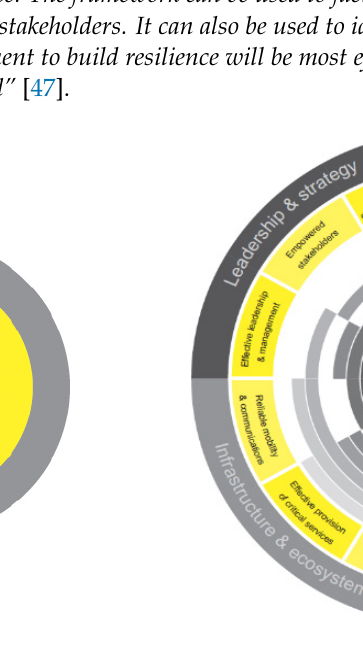
Figure 1. The complex character of city resilience .